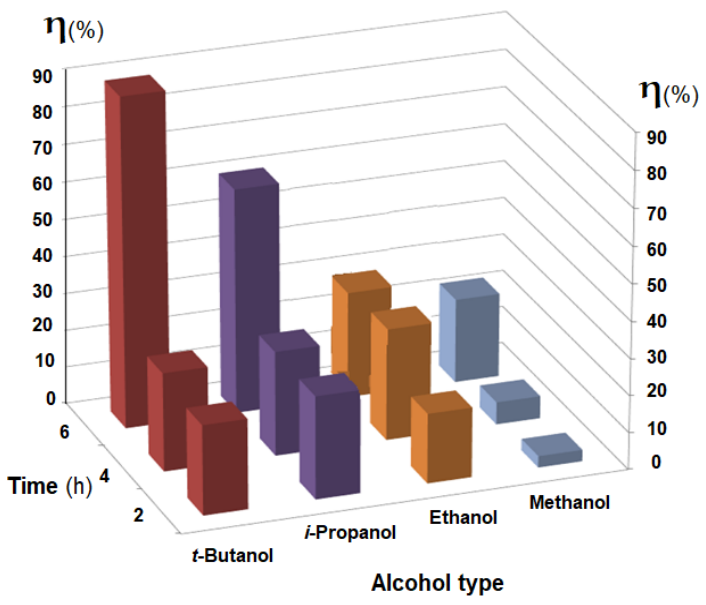
Figure 16. The influence of the nature of the primary alcohol ( t- butanol, i- propanol, ethanol, or methanol) on the conversion ( η %) to the reduction of p- nitrophenol in the solution, depending on the operating time (h).